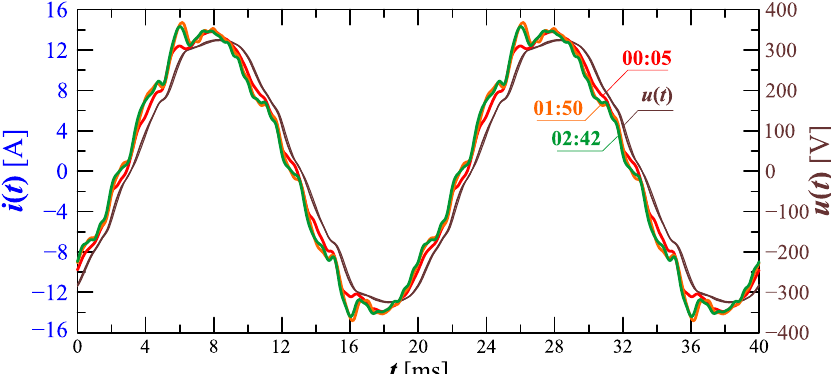
Figure 21. Recreated voltage waveforms u ( t ) and current waveforms i ( t ) recorded at 00:05, 1:50, and 2:42 for Case II.